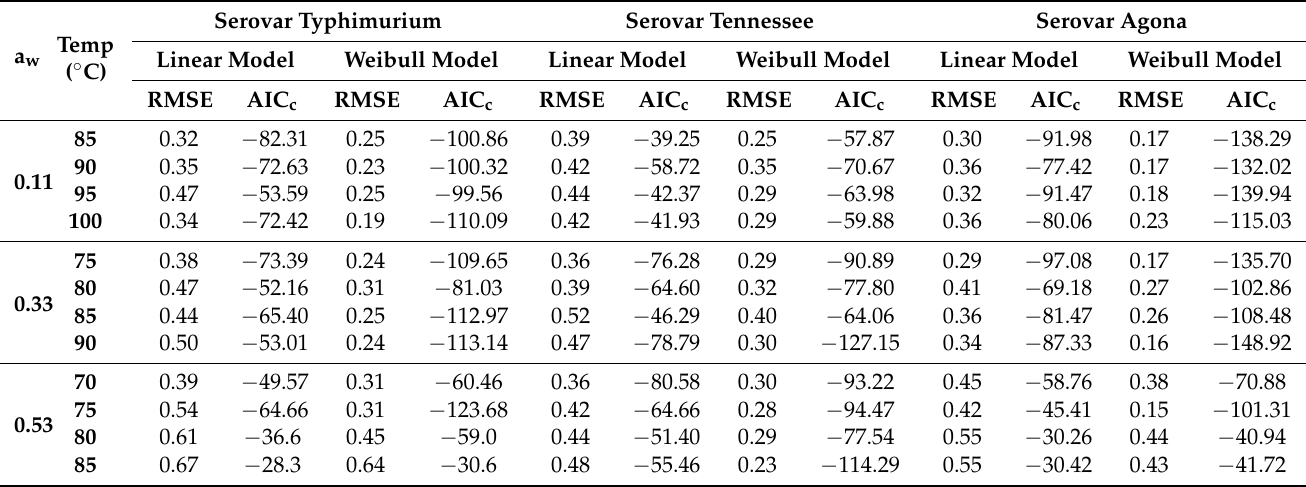
Table 2. Evaluation of the goodness-of-fit of the linear and Weibull models used to describe the inactivation of three Salmonella enterica serovars by means of the root mean square error (RMSE) and the corrected Akaike information criterion (AIC c ) calculated for each water activity and temperature in toasted oats cereal (TOC) containing 25% sucrose.